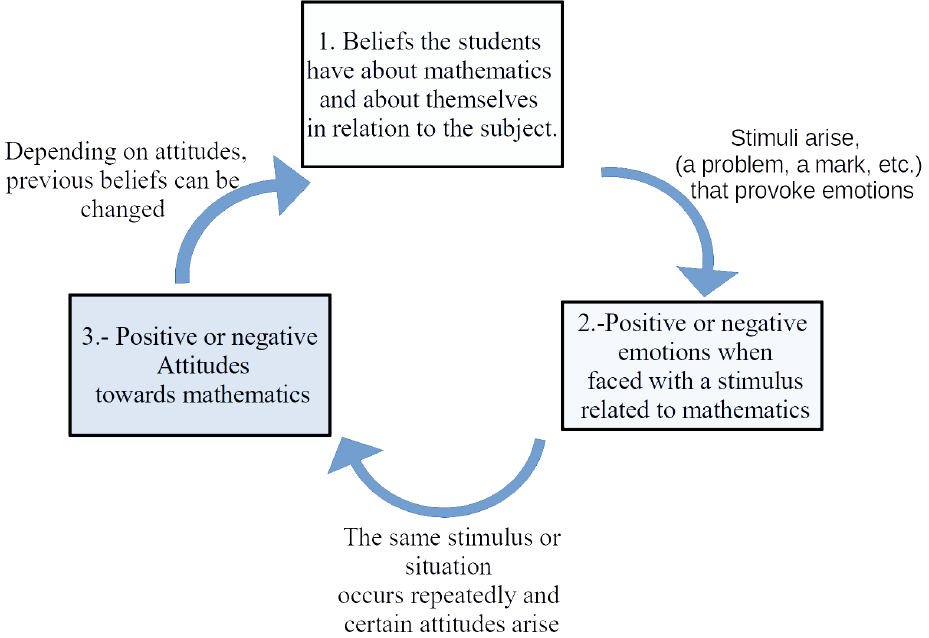
Figure 1. Attitudes and beliefs in